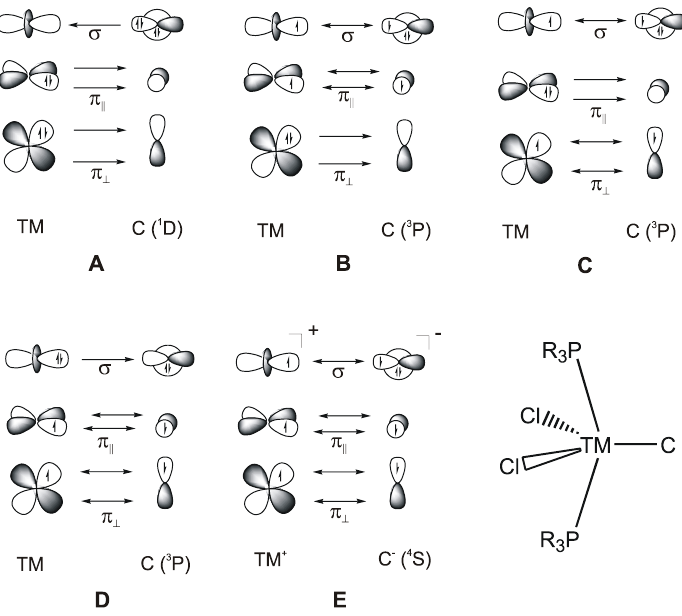
Figure 20. Bonding models ( A – E ) for the bonding between a transition metal (TM) and a naked carbon atom in the compound [(R 3 P) 2 Cl 2 Ru-C].